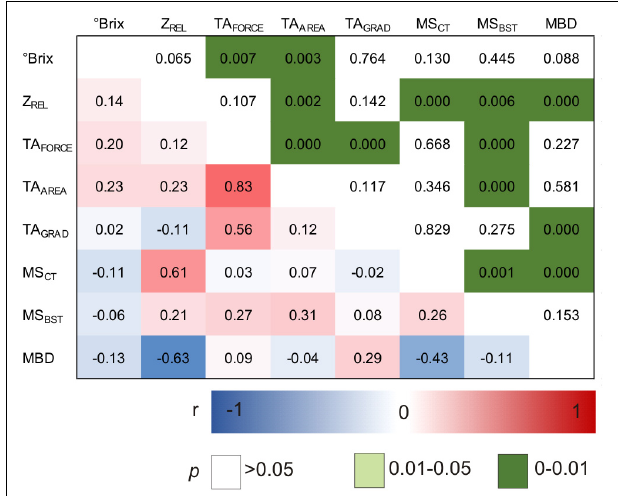
FIGURE 6 | Pearson correlation matrix of investigated phenotypic traits within the subset of ‘Dakapo’ × ’Cabernet Sauvignon’ mapping population. N = 180 genotypes. ◦ Brix, berry sample sugar content; Z REL , berry impedance; TA, texture analysis; TA FORCE , berry skin firmness; TA AREA , whole berry firmness; TA GRAD , berry skin elasticity; MS CT , cuticle thickness; MS BST , berry skin